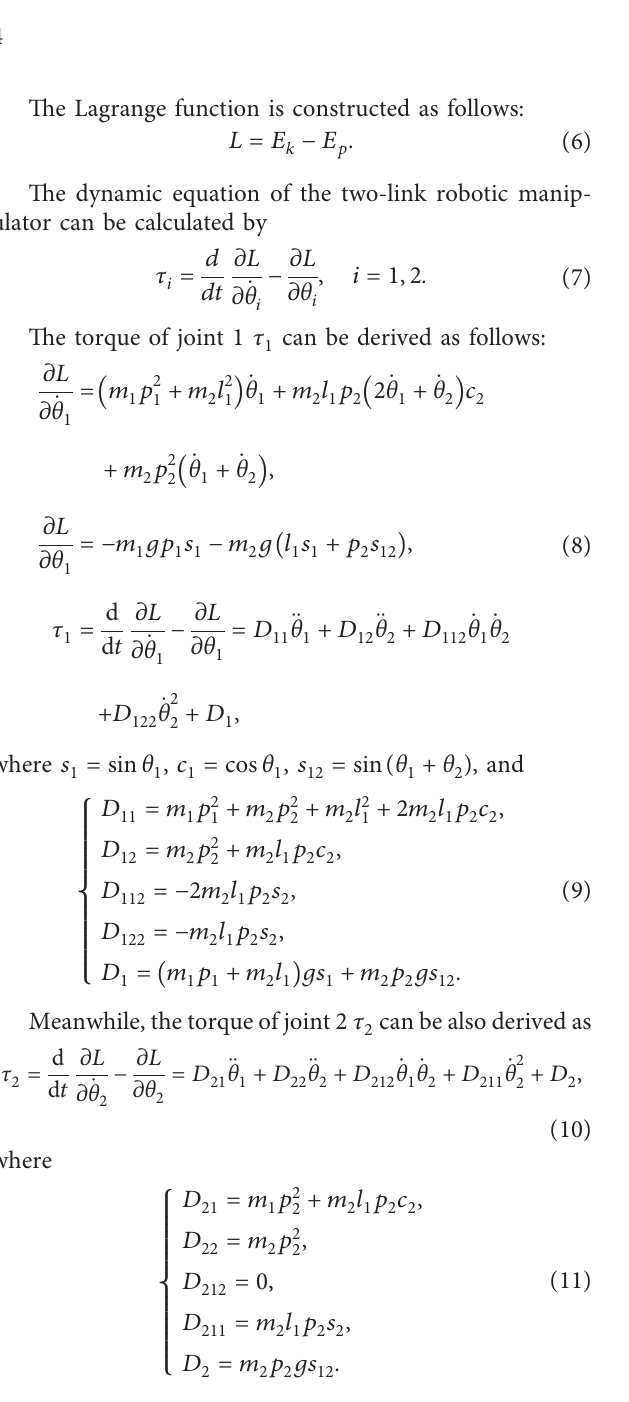
(1) Fuzzification: it takes e and ec as input language variables and K p , K I , and K D as output language variables. The fuzzy subset of input and output variables are expressed as negative big (NB), negative middle (NM), negative small (NS), zero (ZO), positive small (PS), positive middle (PM), and positive big (PB). The domain of e and ec is − 3 3 􏼈 􏼉 , and the domain of K p , K I , and K D are − 0 . 3 0 . 3